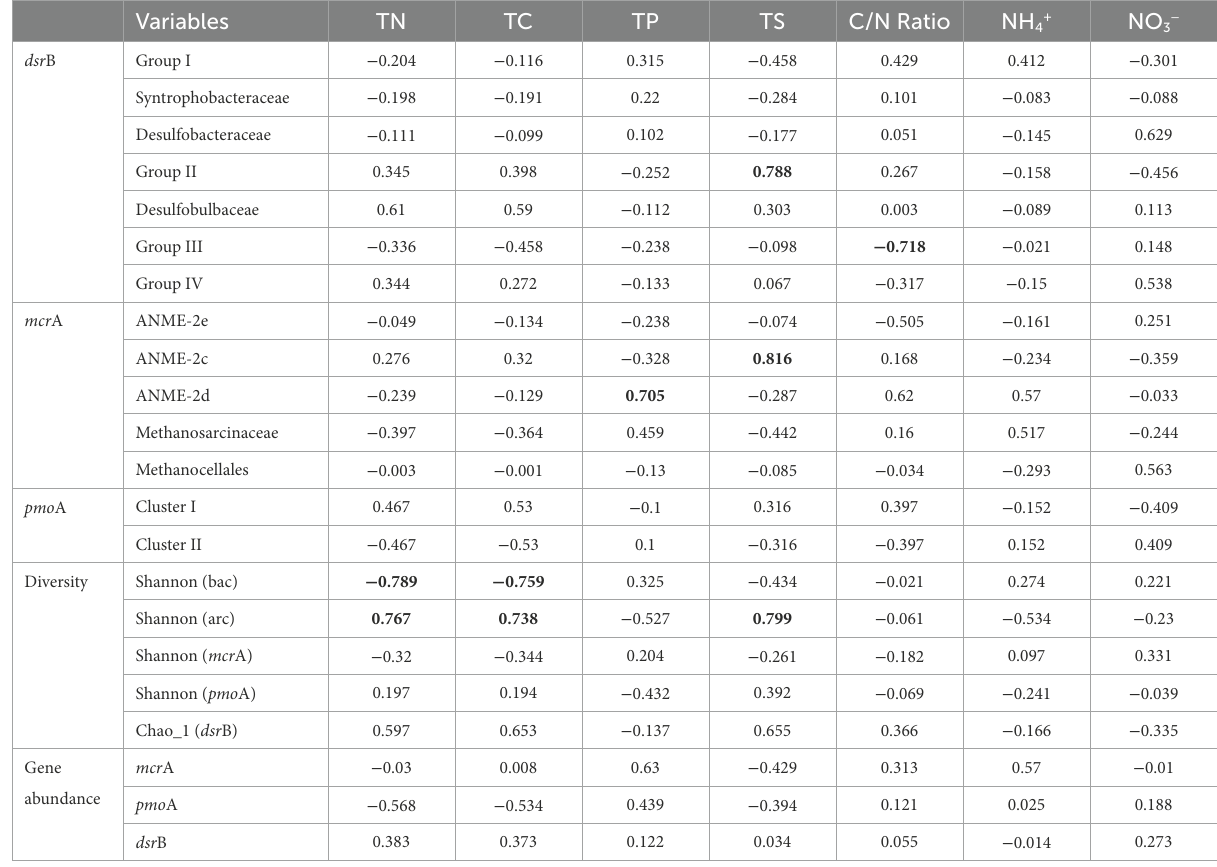
TABLE 2 Pearson correlation matrix among the